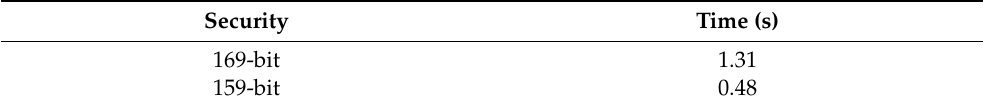
Table 6. SummaryofauthenticationrequestfordifferentlevelsofsecurityonaMSP430F1611microcontroller.